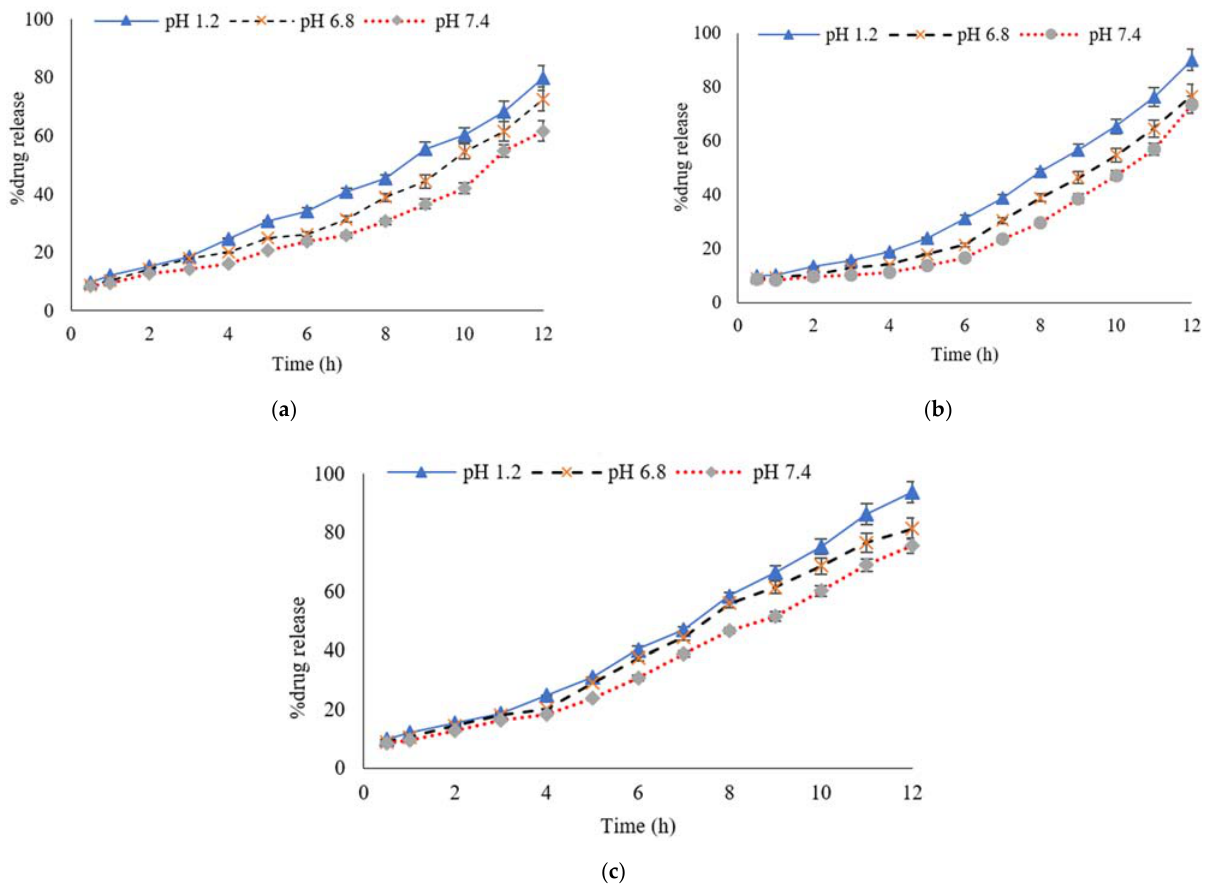
Figure 5. Percentage of MTX release profiles from Gel/PVA hydrogel with polymer concentrations of ( a ) GEL/PVA (7/2.5 g), ( b ) GEL/PVA (7.5/2 g), ( c ) GEL/PVA (8/2 g) at pH 1.2, pH 6.8 and pH 7.4, at 37 °C. Data are expressed as mean ± S.D. and p < 0.01 is considered statistically significant.